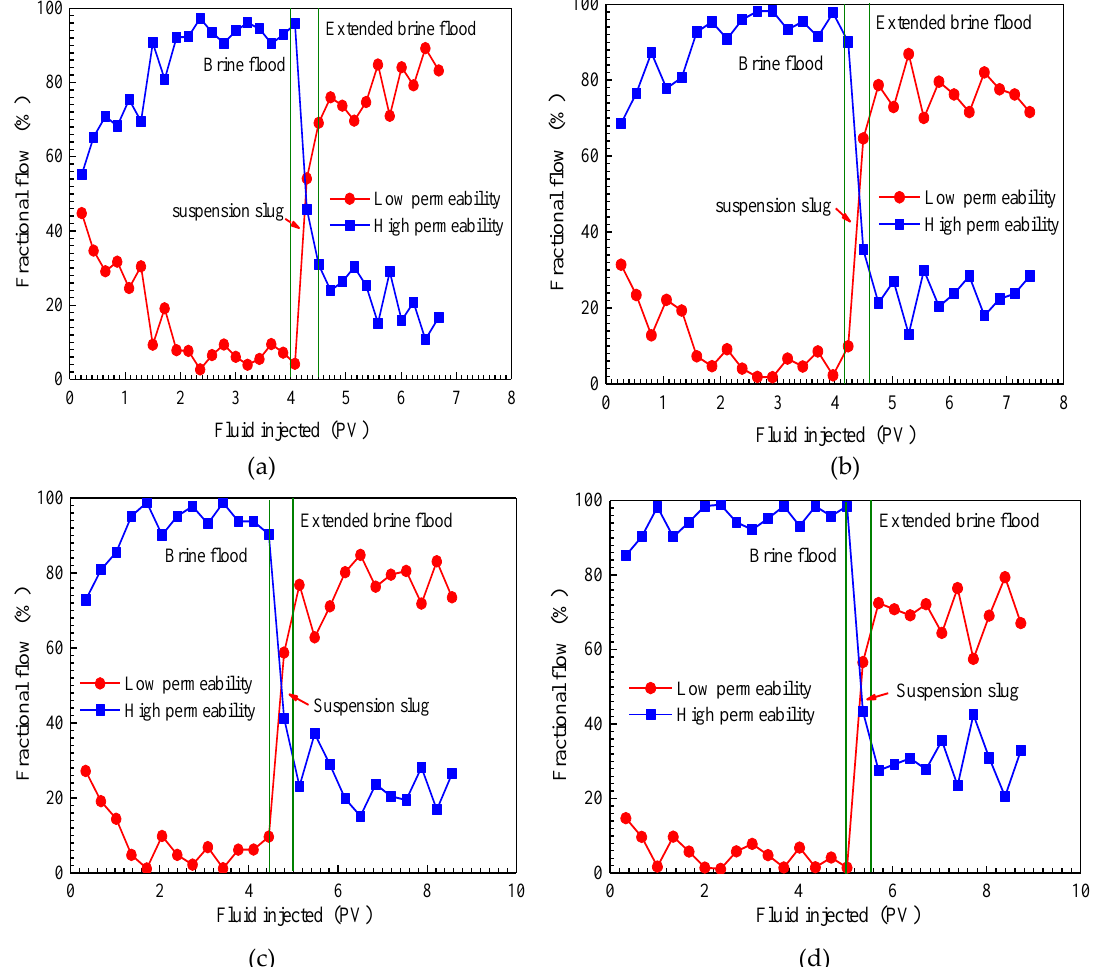
Figure 7. Fractional flow curves of four parallel cores flooding tests. Permeability ratio: ( a ) 1.40; ( b ) 4.36; ( c ) 8.28; ( d ) 15.49.